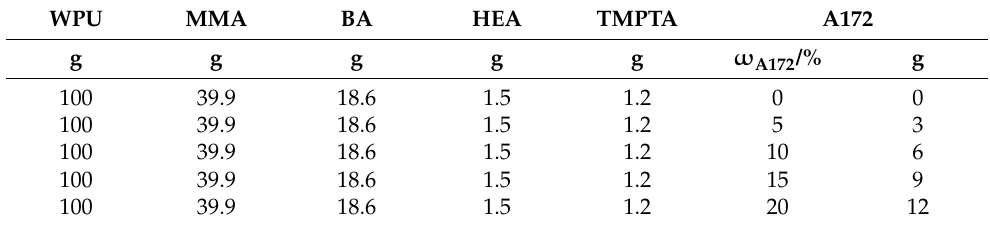
Table 1. The experimental formulation of